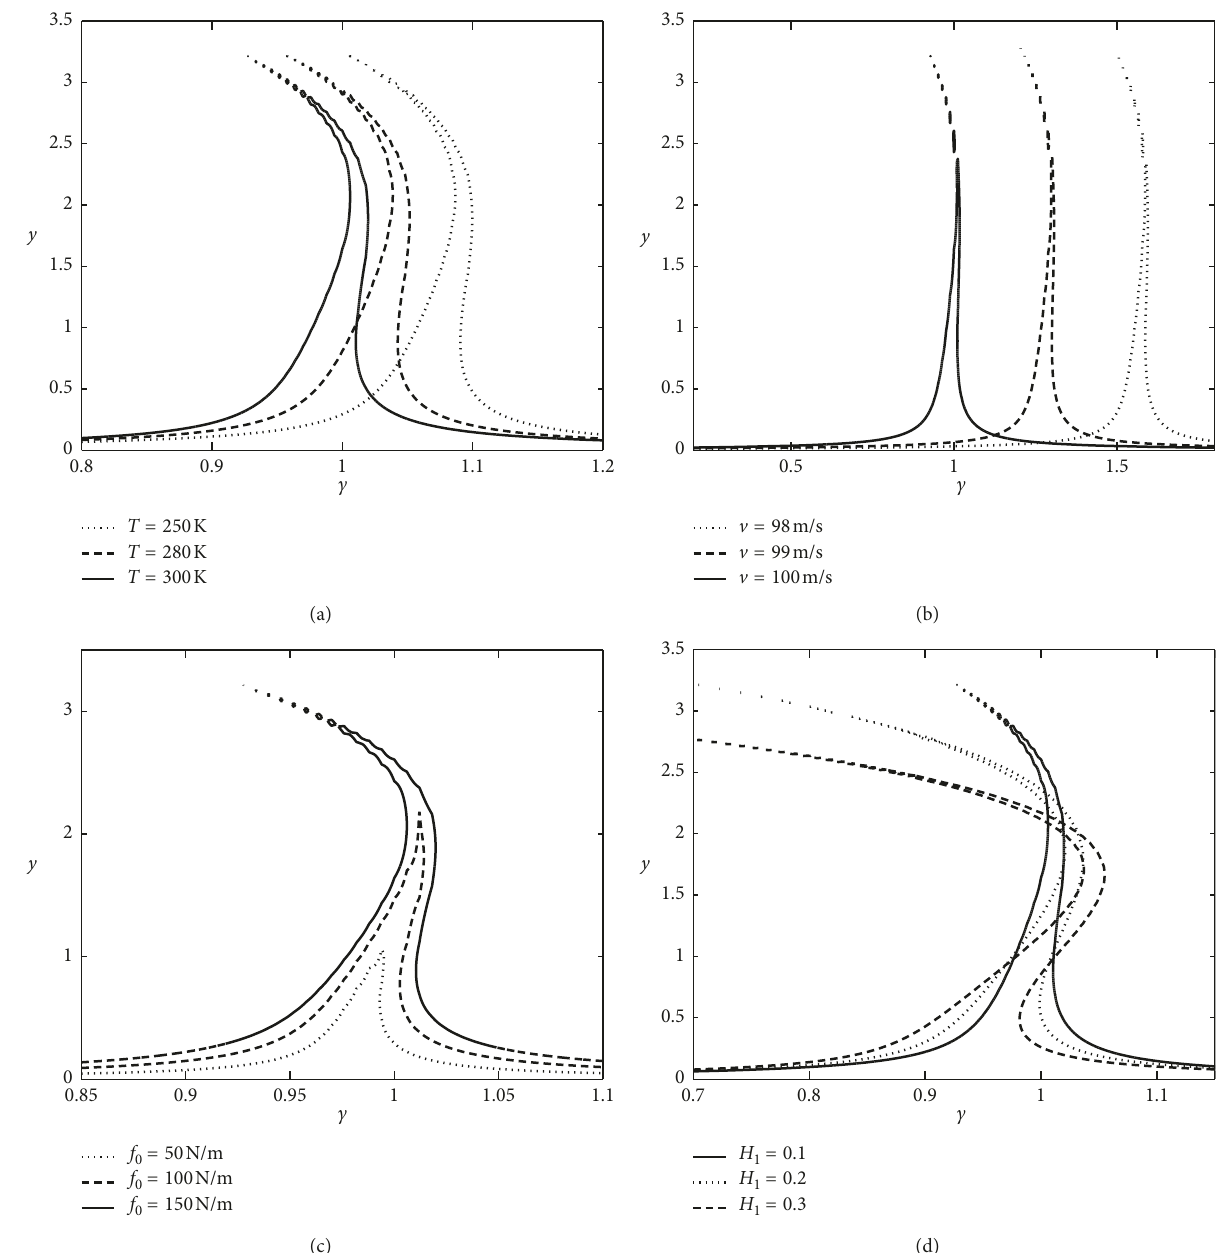
Figure 4: Comparison of response amplitudes of different